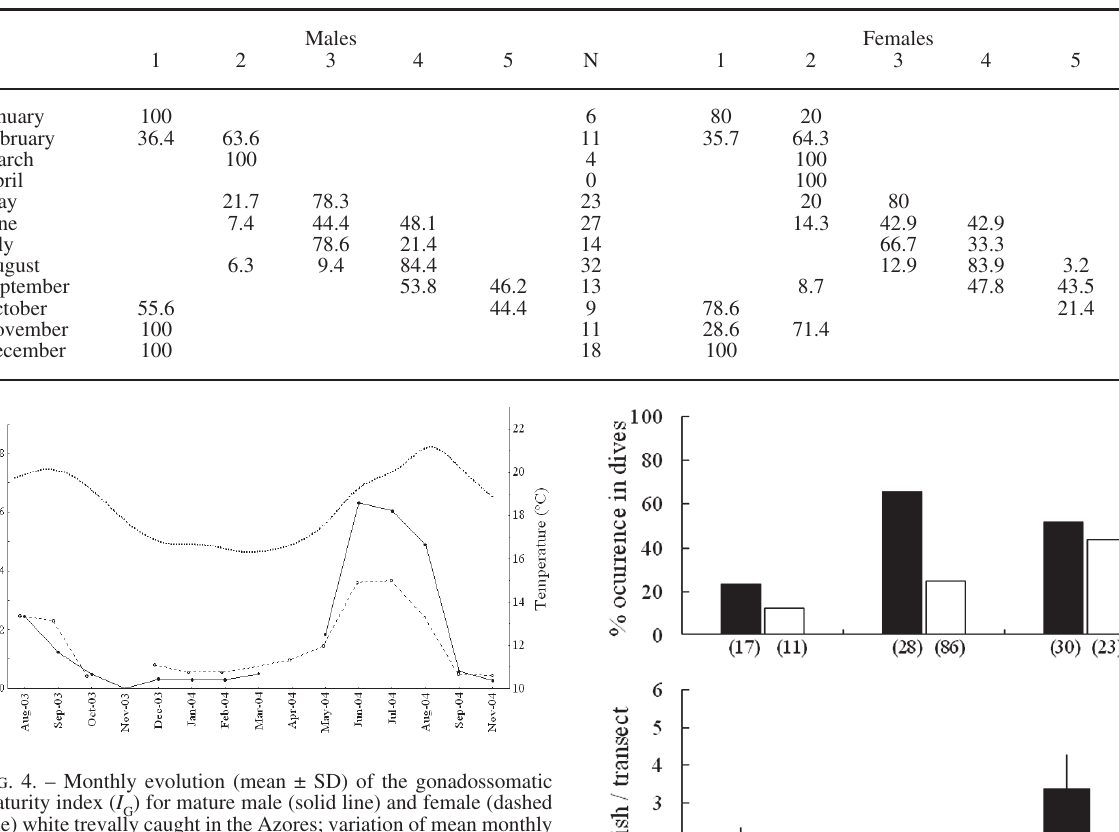
Table 2. – monthly proportion (%) of maturity stages per sex in white trevally: 0=immature; 1=resting; 2=early development; 3=late develop- ment; 4=spawning (ripe); 5=spent.